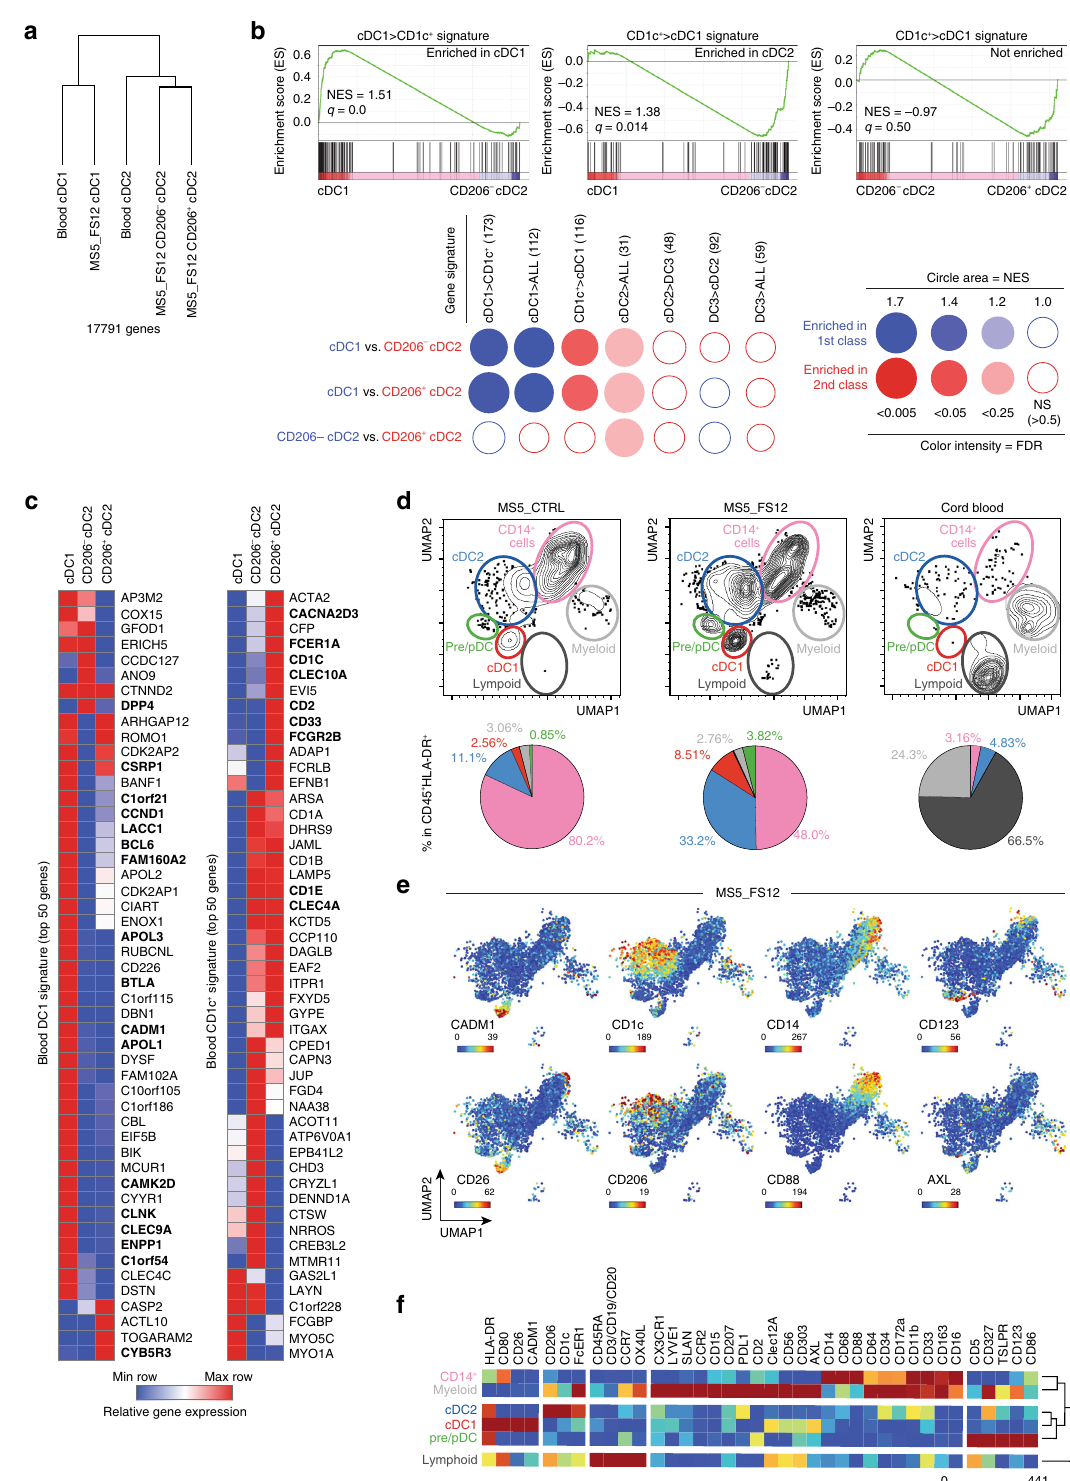
injected two independent plugs of CD34 + HSPCs with either MS5_CTRL or MS5_FS12 in the same recipient mouse (contralateral plugs) (Fig. 5d). We found a relative expansion of human leukocytes in MS5_FS12 as compared to MS5_CTRL contralateral plugs (Fig. 5d). We conclude that MS5_FS12 does not ef fi ciently provide soluble factors enabling human